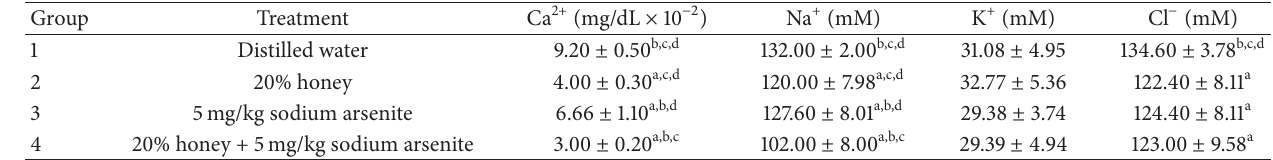
Table 2: The electrolyte levels in brain (cerebrum and cerebellum) after Acacia honey and sodium arsenite administration in vivo . Group